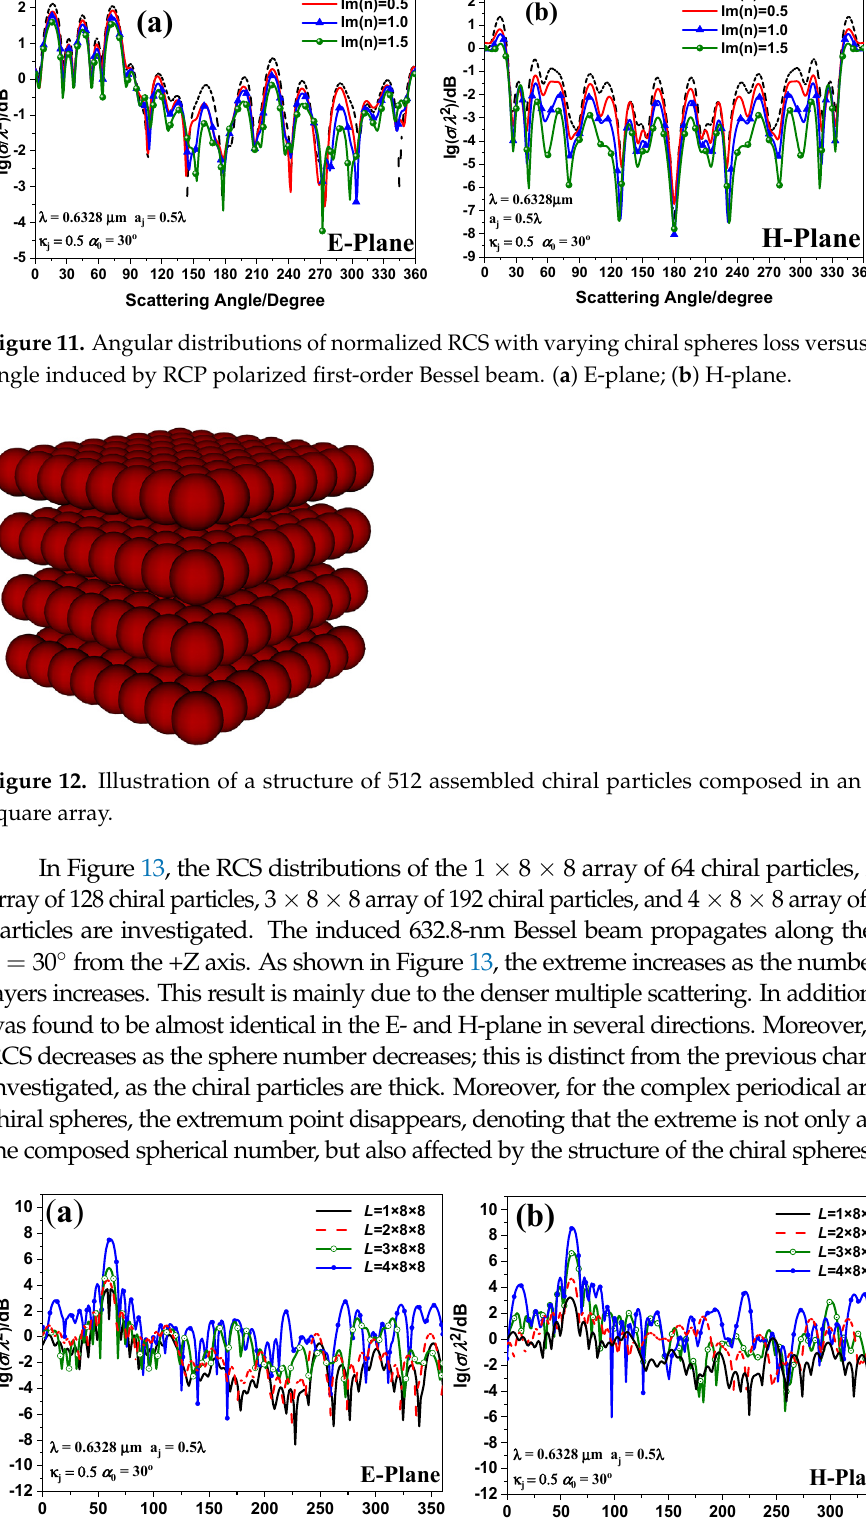
Figure 13. Angular distributions of normalized RCS of four structures composed of varying quan- titative chiral particles versus the scattering angle from an RCP polarized first-order Bessel beam. ( a ) E-plane; ( b ) H-plane.